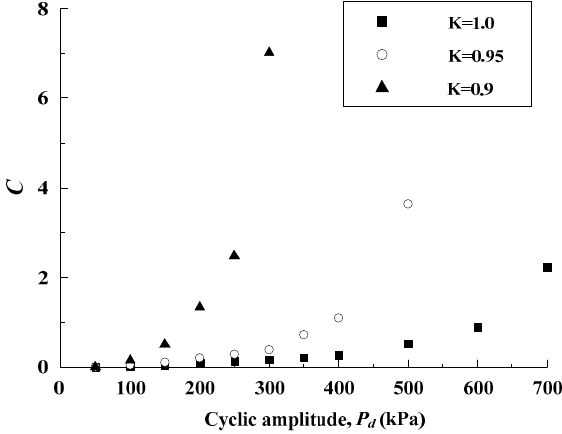
Figure 15. Comprehensive rate evaluation coefficient against cyclic amplitude.